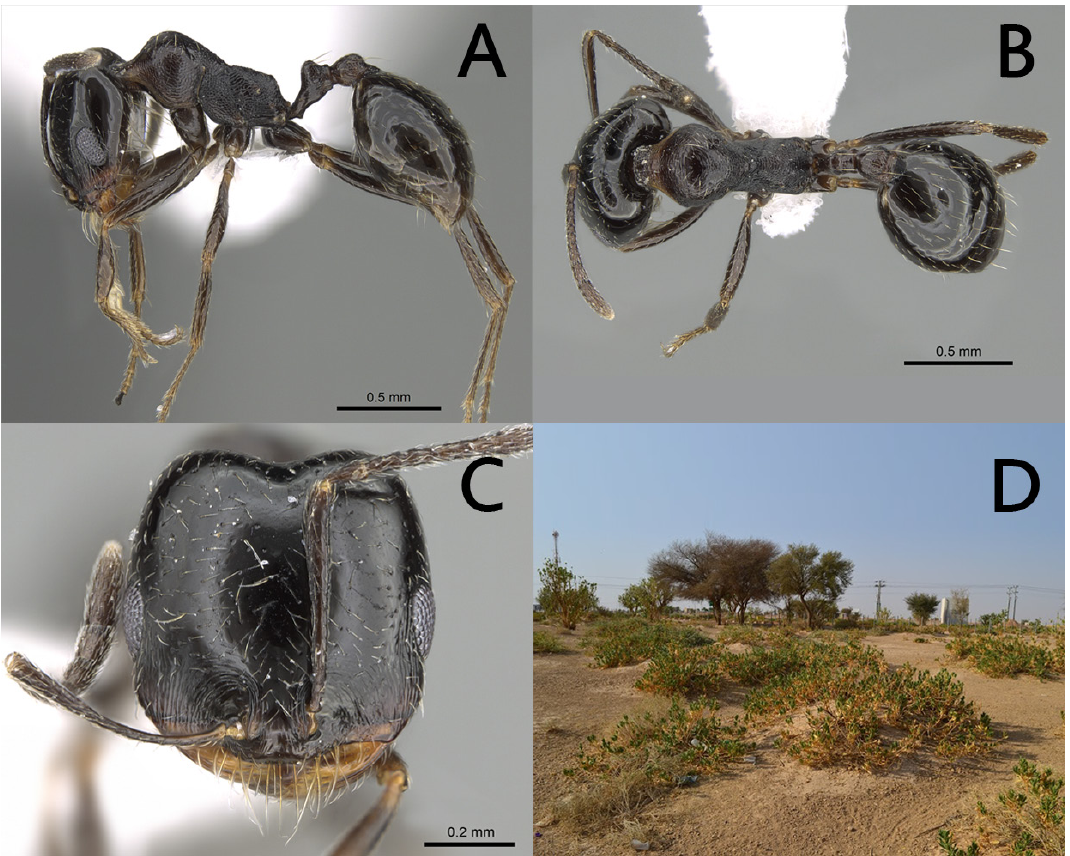
Fig. 6. Trichomyrmex almosayari sp. nov., paratype, worker (CASENT0914921). A . Body in profile. B . Body in dorsal view. C . Head in full-face view (photos: Michele Esposito). D . Type locality (photo: Shehzad